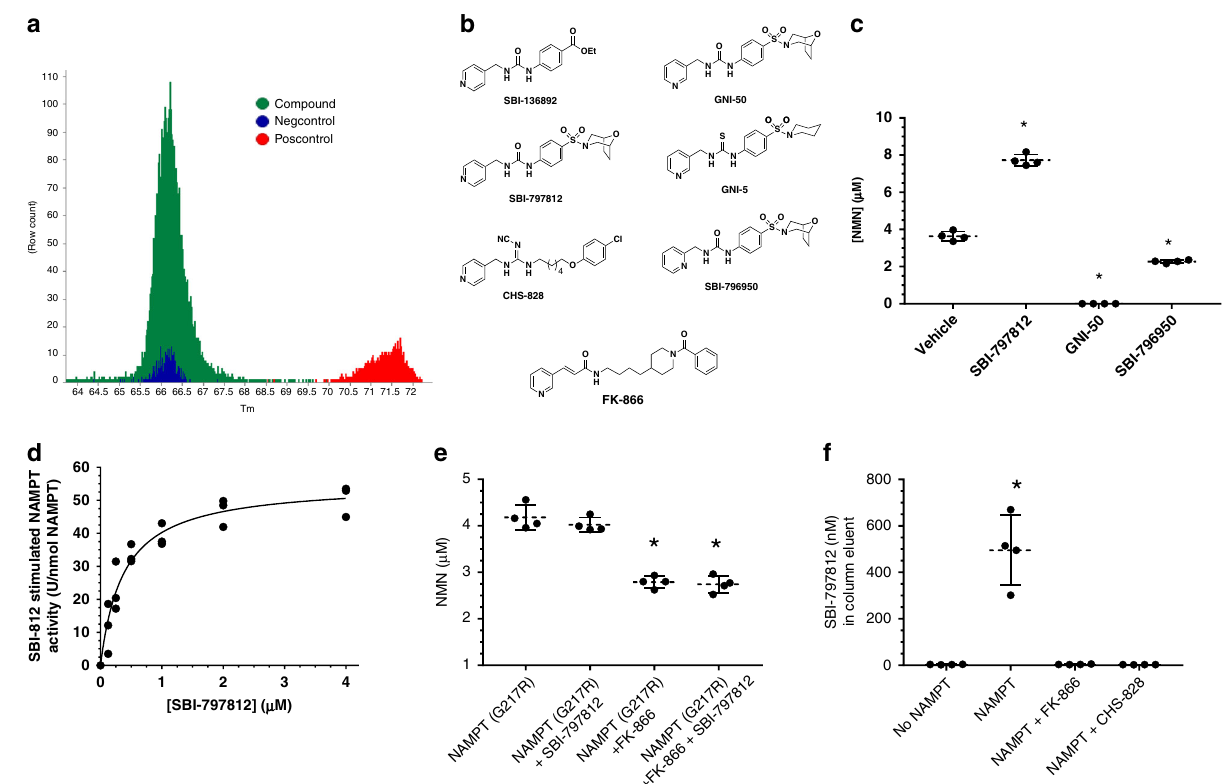
Fig. 1 Discovery of SBI-797812, a small molecule NAMPT activator. a Compiled melting temperature (Tm) data for human NAMPT treated with chemical compounds ( N = 57,004) and tested with the PTS assay protocol (green). NAMPT ligands produced an upward Tm shift. DMSO was the Neg Control (blue). CHS-828 (20 μ M) was the Pos Control (red). b Structures of NAMPT activators and inhibitors. c Pivotal role of the 4-pyridyl nitrogen in SBI-797812 for NAMPT activation. NAMPT (30 nM), NAM (10 μ M), PRPP (50 μ M), ATP (2 mM) were incubated 1 h at 37 °C with vehicle or 2 μ M SBI-797812, GNI- 50, or SBI-796950. NMN was detected using the fl uorescence assay. Data are expressed as means± s.d.; n = 4. *, p < 0.0001 compared to Vehicle. One- way ANOVA with Dunnett ’ s multiple comparisons test was used. d Dose-dependent activation of human NAMPT by SBI-797812. NMN production assay was performed as above but with 25 μ M NAM and varying SBI-797812. NMN levels were normalized for basal NMN production without SBI-797812. Three replicates were run for each SBI-797812 concentration. Michaelis-Menten curve fi t was produced with GraphPad Prism software. e NAMPT(G217R) mutant was resistant to both SBI-797812 and FK-866. NAMPT(G217R) (50 nM) was incubated with NAM (10 μ M), PRPP (50 μ M), ATP (2 mM) and (where indicated) 1 μ M SBI-797812 and/or 1 μ M FK-866. Reactions were performed for 1 h at 37 °C. NMN was detected with the fl uorescence assay. Data are expressed as means ± s.d.; n = 4. * p < 0.0001 compared to NAMPT(G217R). One-way ANOVA with Dunnett ’ s multiple comparisons test was used. f FK-866 and CHS-828 blocked binding of SBI-797812 to NAMPT. SBI-797812 was added to T8MD-Tween buffer with ATP or the same buffer